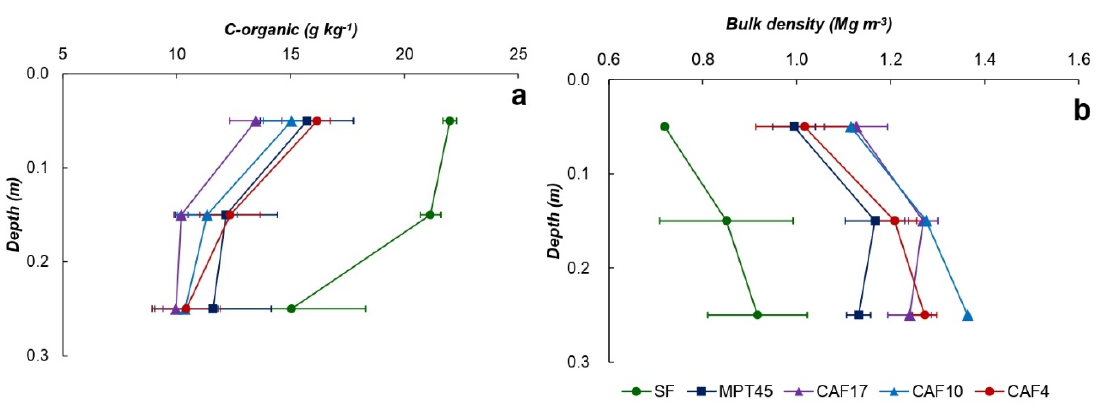
Figure 4. Surface soil (0–30 cm depth) soil organic carbon status ( a ) and bulk density ( b ) of secondary tropical forest (SF), multistrata agroforestry that is 45–68 years old (MAF45), cocoa agroforestry that is 17–34 years old (CAF17), cocoa agroforestry that is 10 years old (CAF10), and cocoa agroforestry that is 4–5 years old (CAF4). Bars are standard errors of the means.